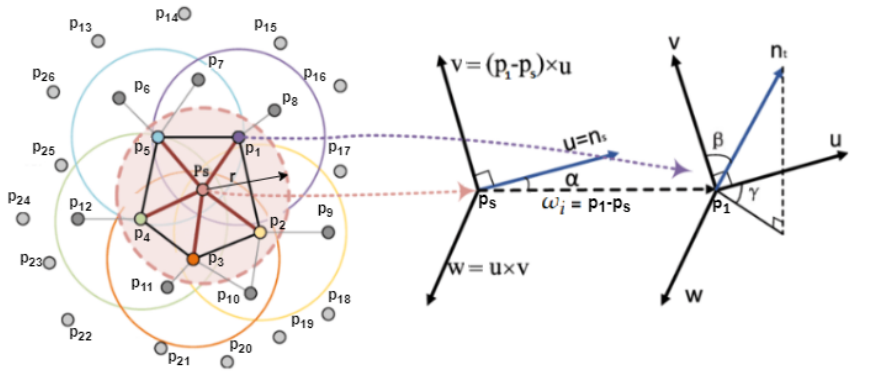
Figure 3. Calculating of FPFH. The query point is p s and its neighbors are: p 1 , p 2 , p 3 , p 4 , p 5 . The angular features are calculated for every point pair connected with a black